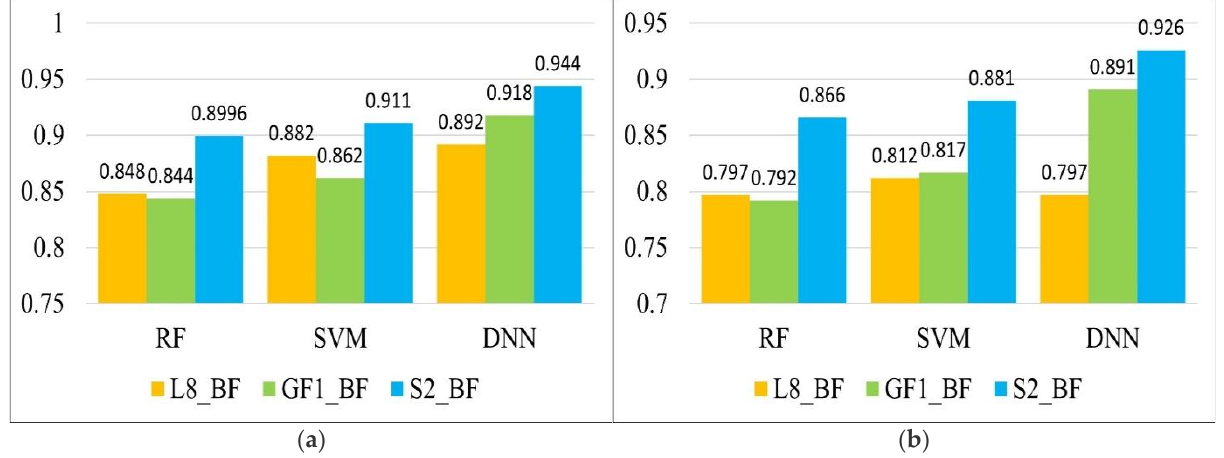
Figure 11. Extraction results of Chinese pine using BI dataset. ( a – c ) The extrction results using Sentinel-2; ( d – f ) The extrction results using Gaofen-1; ( g – i ) The extrction results using Landsat-8 OLI.